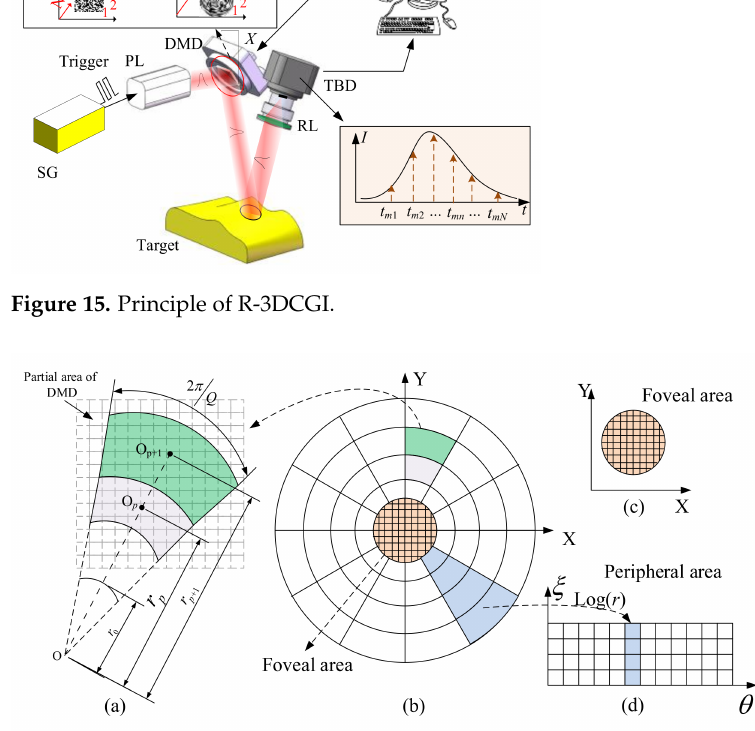
Figure 16. Retina-like structure on the DMD. ( a ) Details of the peripheral area of the retina-like structure. ( b ) Retina-like structure including the foveal and peripheral areas. ( c ) Foveal area. ( d ) Peripheral